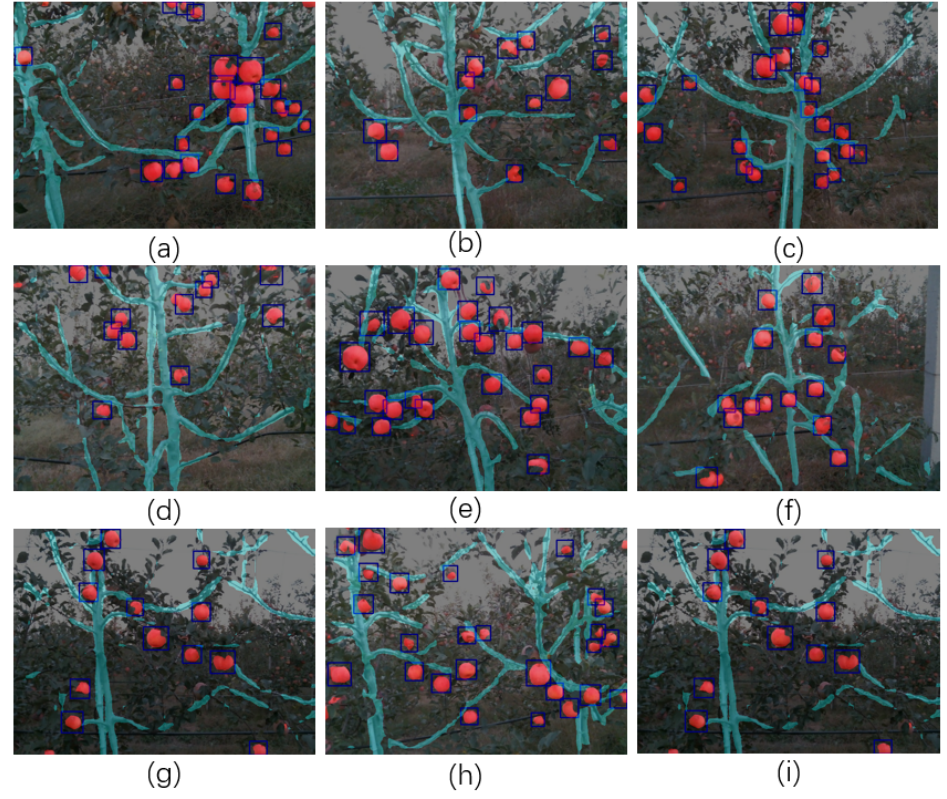
Figure 10. ( a – i ) show the segmentation and detection of apples and branches in orchard environment by using the